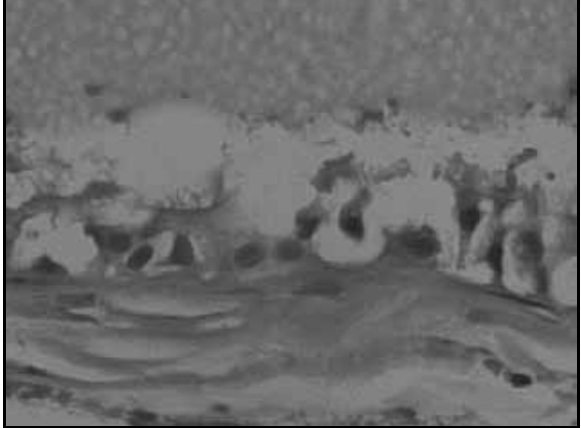
Figura 3 – Microscopia do nódulo que mostra revestimento por epitélio colunar